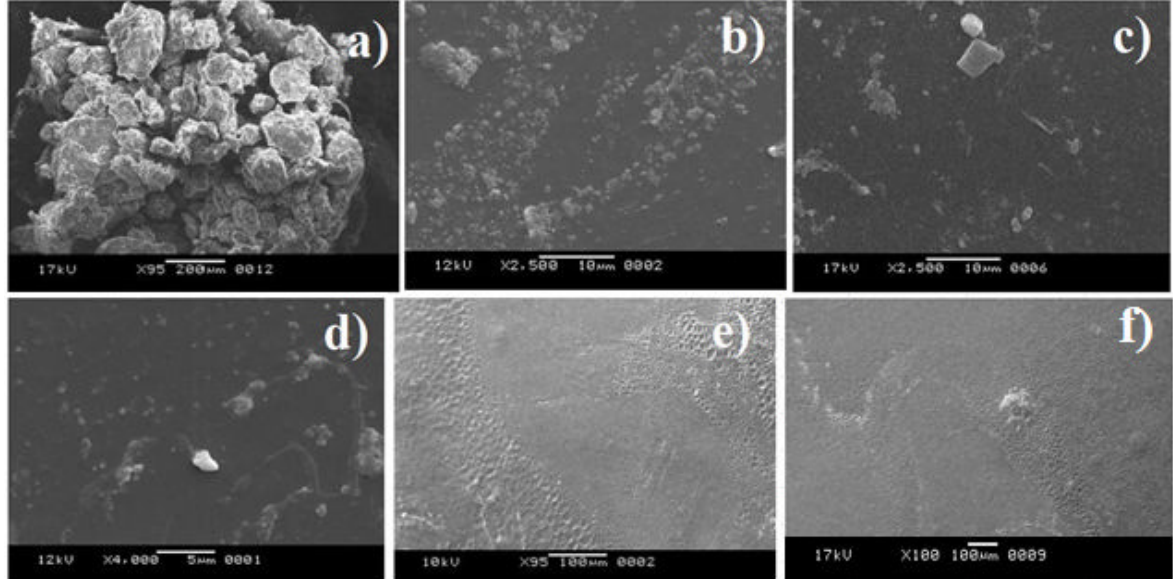
FIGURE 7 - Scanning electron micrographs of a) OND-PVP K-30 1:5 w/w SD; b) blank patch; c) pure drug loaded patch with 40% PEG; d) pure drug loaded patch with 50% DBP; e) SD loaded patch with 40% PEG; f) SD loaded patch with 50%